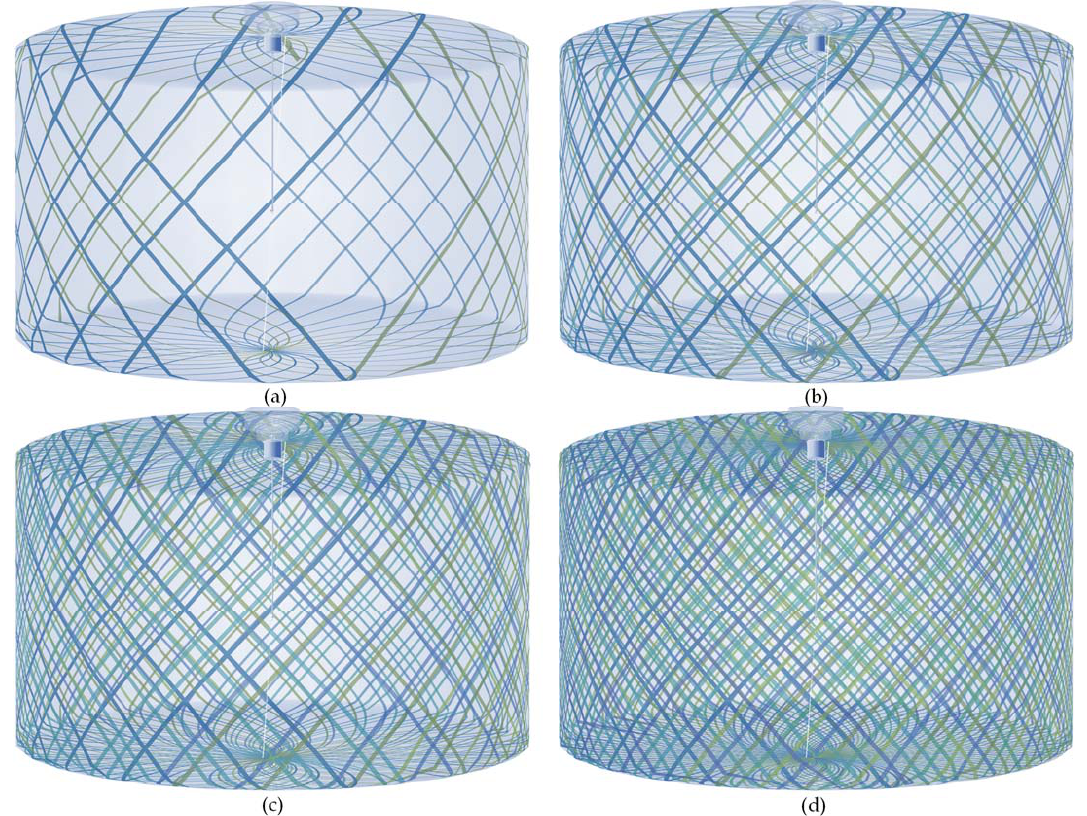
Figure 2. Chemical cleaning process.